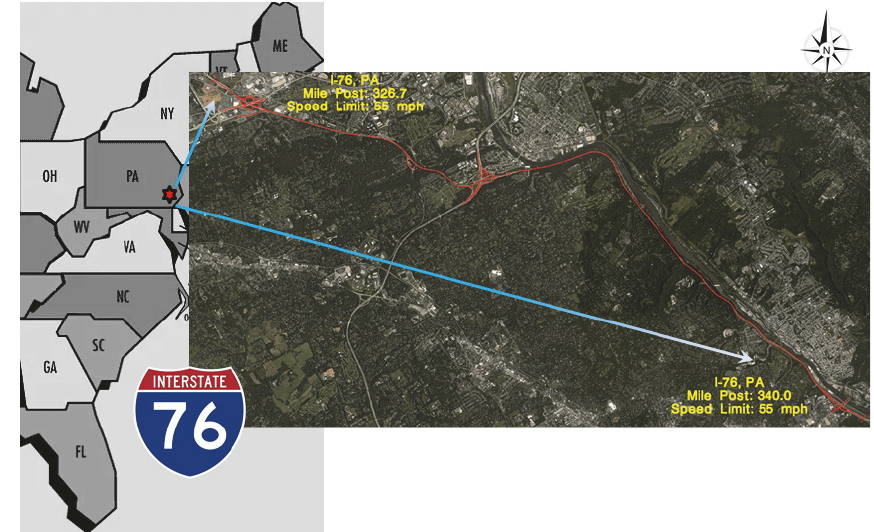
Figure 3: Study area, I-76 (source: Microsoft’s Bing